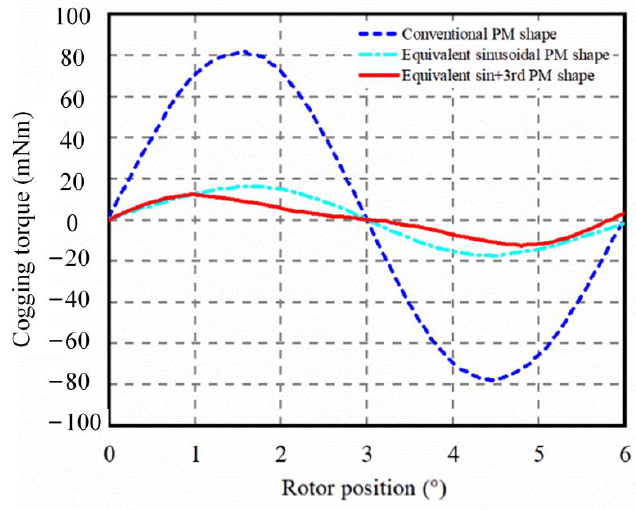
Figure 13. Comparison results of no-load cogging torque of different pole structure.